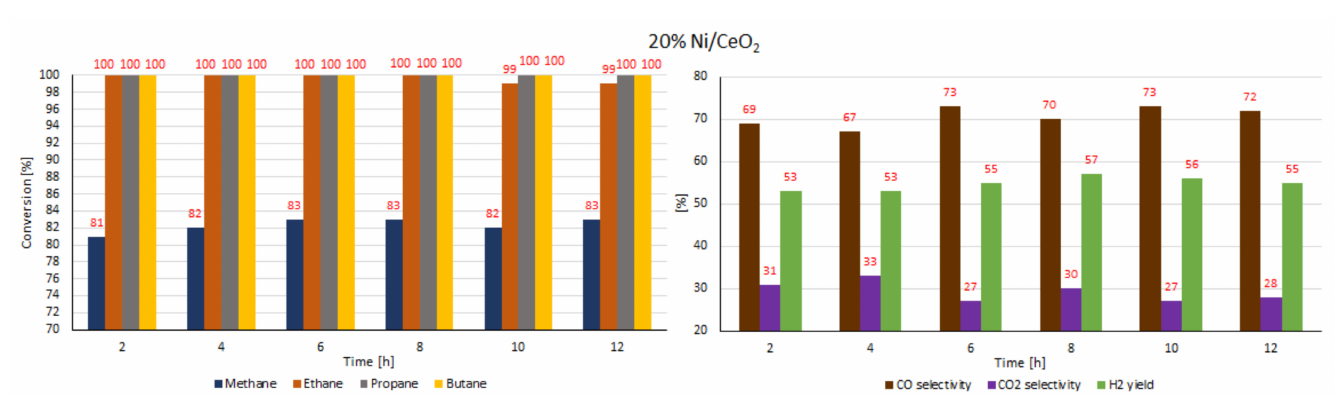
Figure 22. Results of the time-on-stream catalytic tests performed over 12 h of the OSR of LNG reaction on a 20% Ni/CeO 2 catalyst.